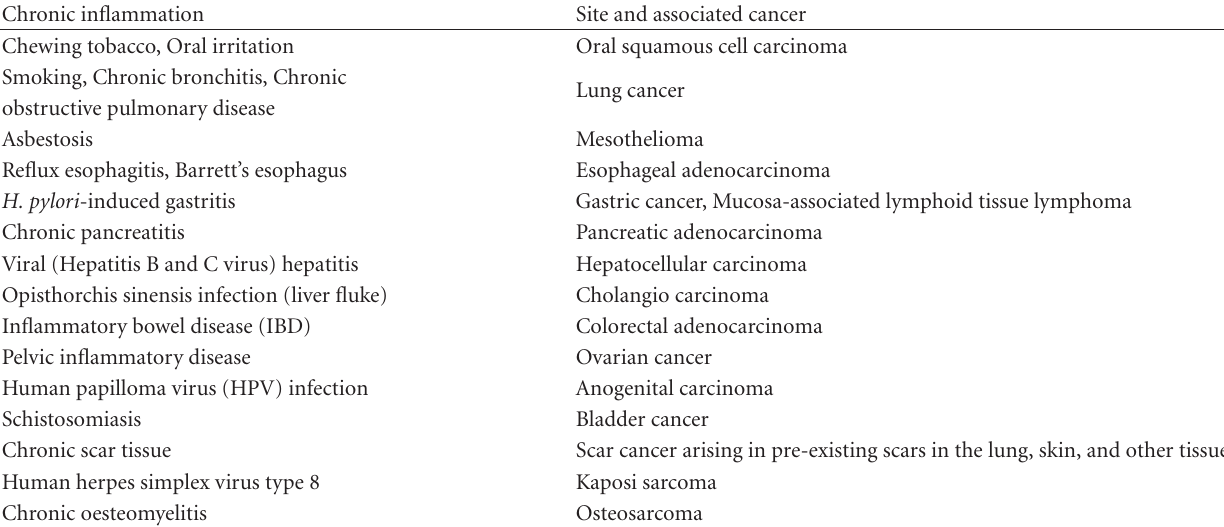
Table 1: Inflammation and cancer in various